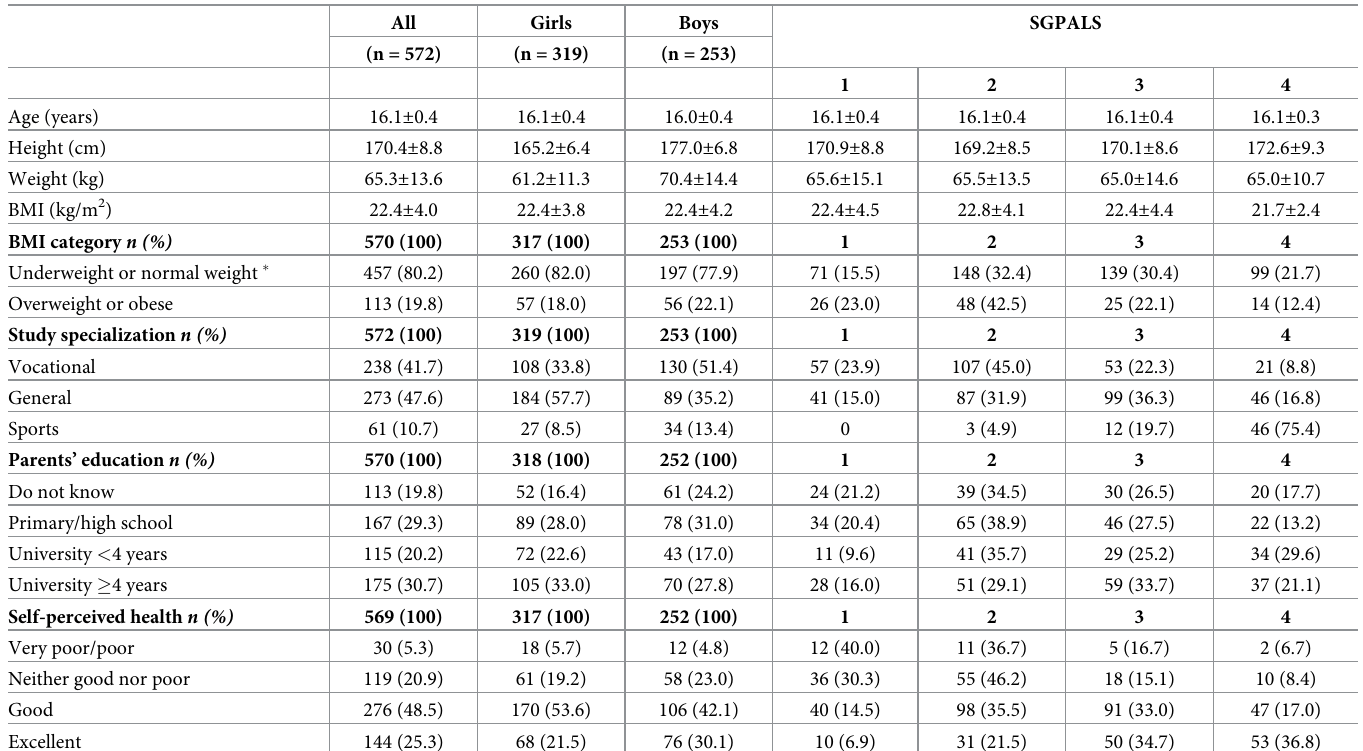
Table 2. Characteristics of boys and girls, the Fit Futures Study